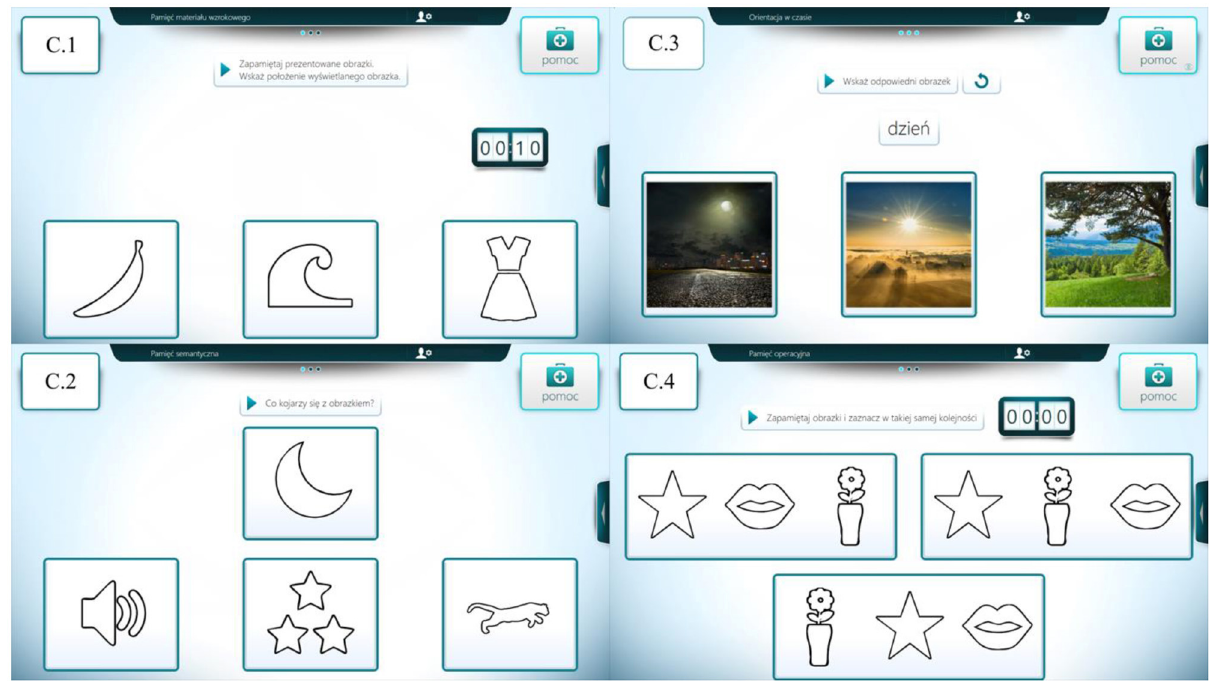
Frontiers in Neurology |